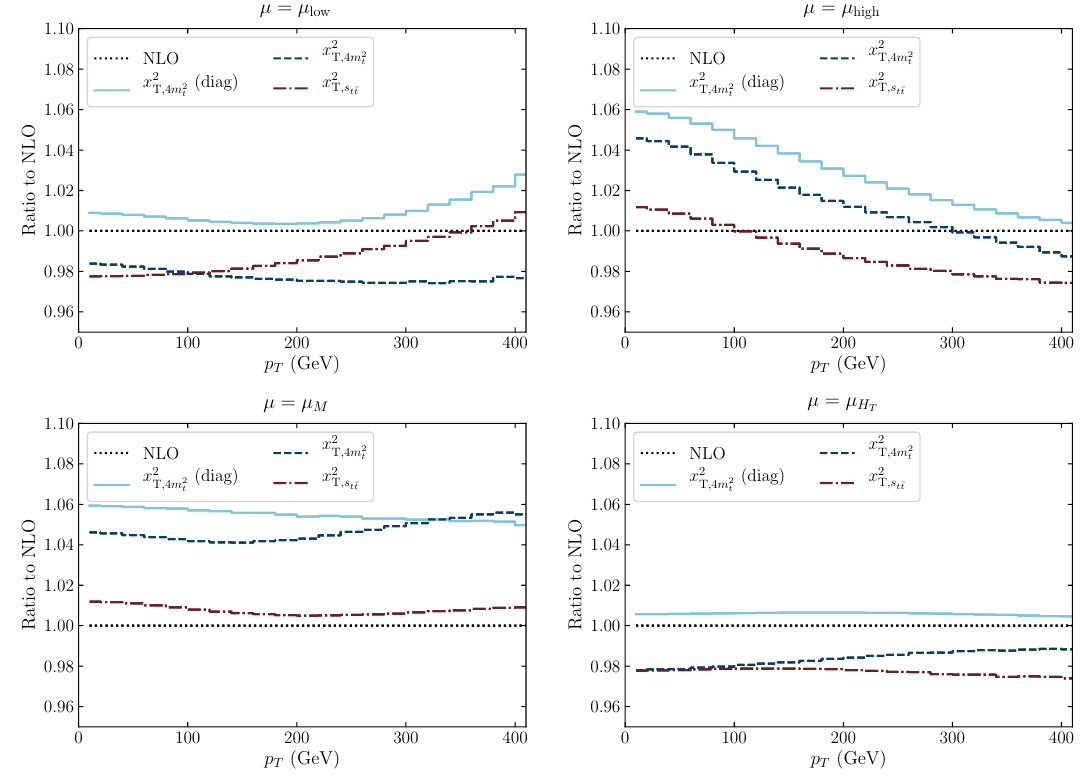
Figure 7 . Ratios of the various resummed transverse momentum distributions to the NLO one for the scale choices µ = µ (upper left), µ = µ (upper right), µ = µ (lower left), and µ = µ low high M H T (lower right). The ratios obtained using the threshold variable x 2 and x 2 are indicated by the T,s t ¯ t T, 4 m 2 t dashed dark-blue and the dash-dotted red lines respectively. The result that is obtained using the approximated form of the soft-anomalous dimension matrices is indicated by the solid light-blue